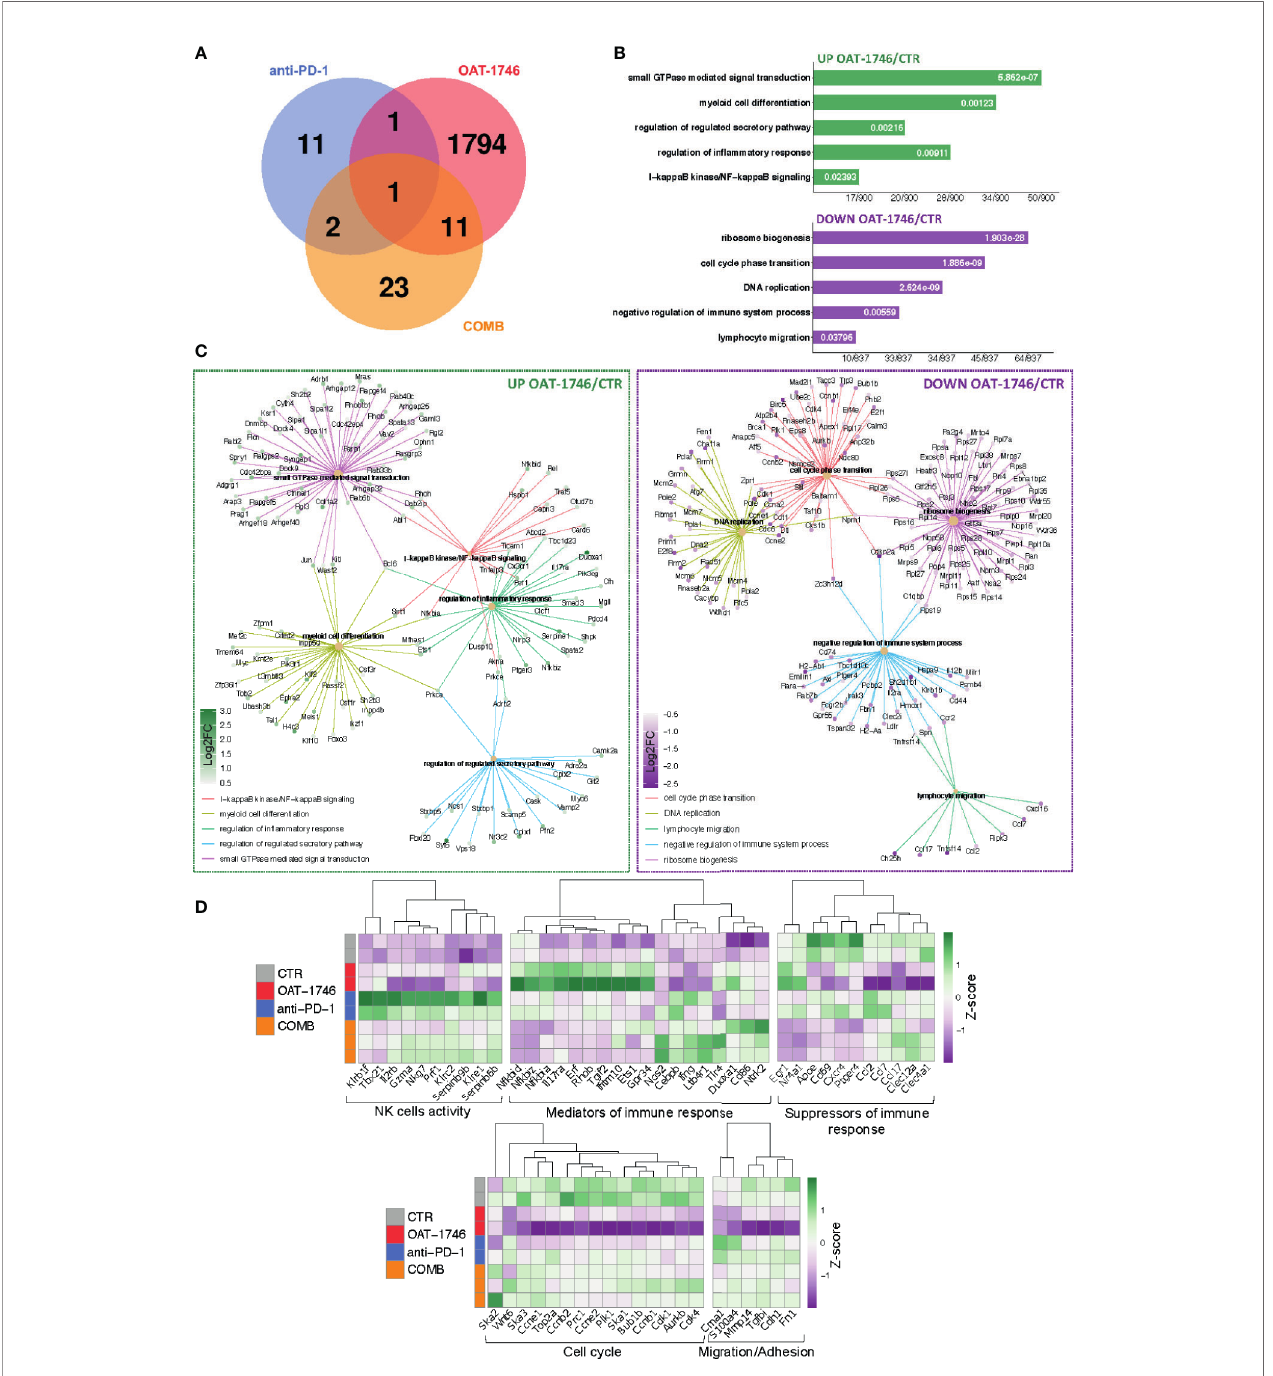
FIGURE 6 | Transcriptomic pro fi les of CD11b + from OAT-1746-treated mice show reduction of the pro-tumor phenotype genes and upregulation of gene expression indicative of antitumor responses. (A – D) Gene expression pro fi ling was performed by RNA-seq of CD11b + cells from the tumor-bearing hemispheres of mice from the experimental groups at day 21 post-implantation. (A) Venn diagram showing the number of differentially expressed genes (DEG) between OAT-1746, anti-PD-1 and COMB compared to the CTR group (p adj <0.05). (B) Functional enrichment analysis with Gene Ontology (GO) biological processes for up- and downregulated genes in OAT-1746 compared to CTR. Enriched GO pathway names are shown, the size of the bars indicates the ratio of genes (a number of genes annotated to the pathway/total number of DEGs with adjusted p-values < 0.05). (C) Graphical representation of selected overrepresented categories among DEGs in the OAT-1746 versus the CTR group (D) Z-score heatmaps for selected genes represent the relative change in gene expression in the CD11b + cells from OAT- 1746, anti-PD-1 or COMB treated